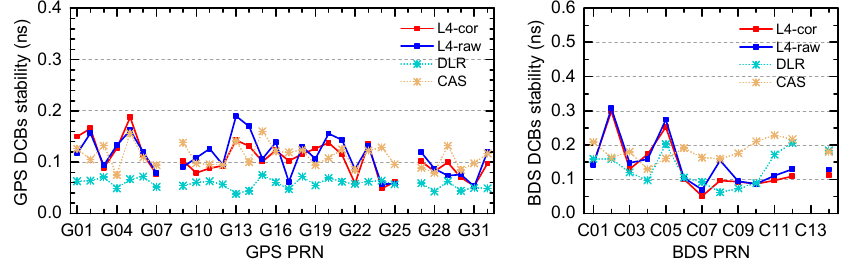
Figure 4. Monthly STD values of the GPS and BDS satellite DCBs. The L4-cor, L4-raw, DLR and CAS solutions are given in different colors.